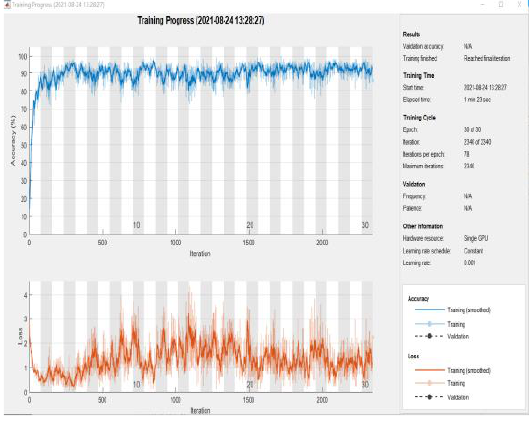
Figure 11 . Model test result graph.